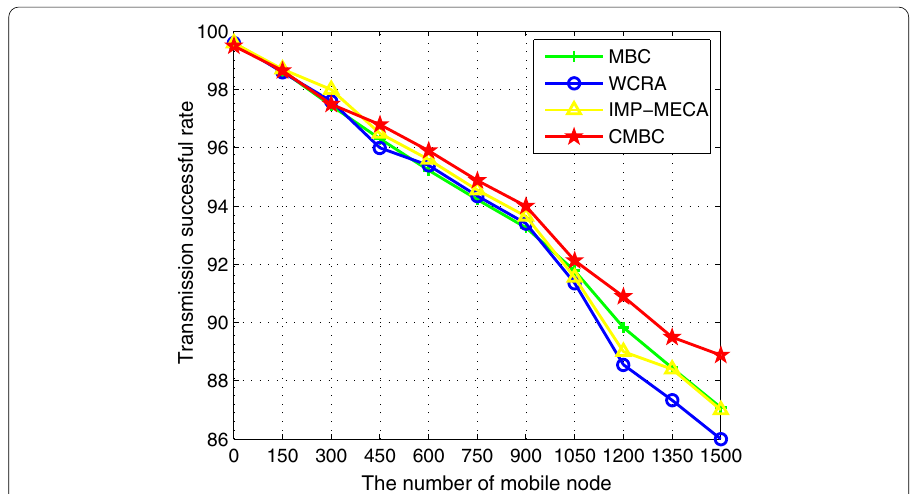
Fig. 5 Results comparison between the number of mobile node and the transmission success rate